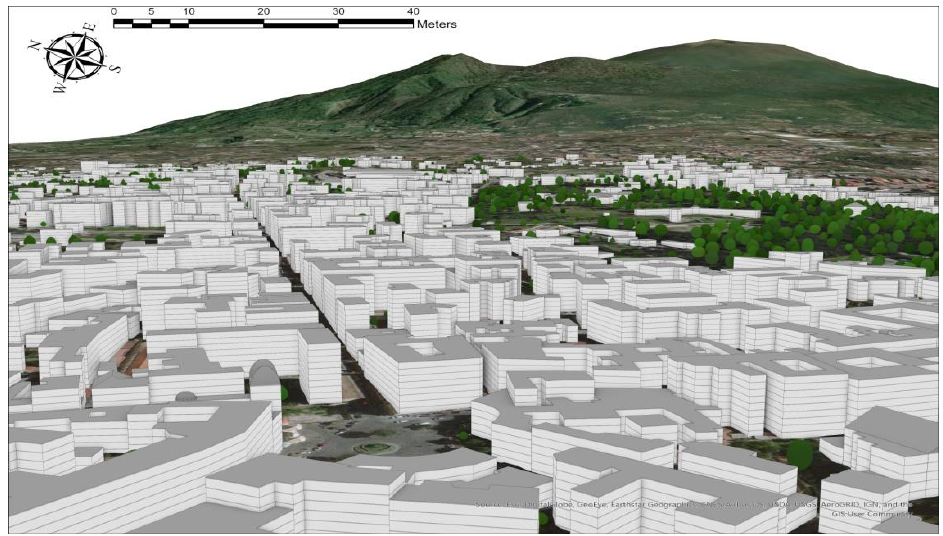
Figure 4. 3D Urban Model of the city of Portici including buildings and vegetation derived by geographical information systems (GIS) and LiDAR data. View of the Park of the Reggia and the main square–Piazza San Ciro.